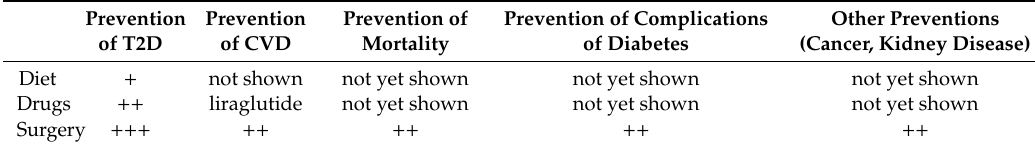
Table 1. Established e ff ects of di ff erent approaches in prevention of